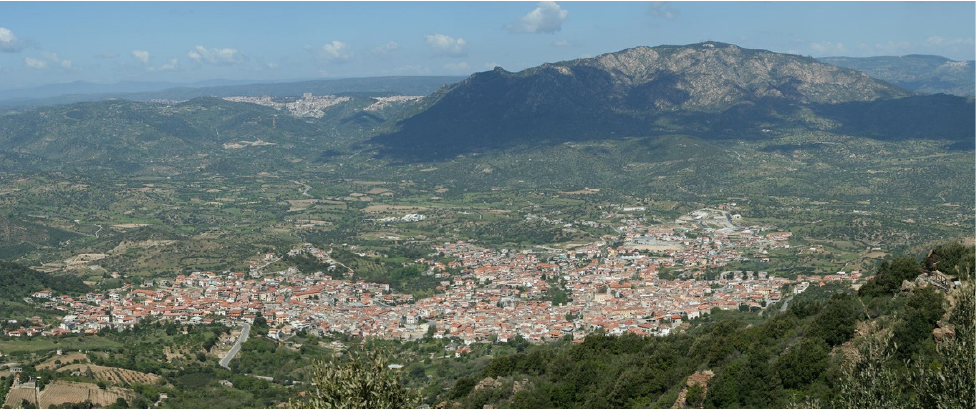
Figure 11. View of the mountainous regions surrounding Oliena (‘Oliena-Nuoro-Orune’. by Rafael Brix 2006/Wikimedia Commons is released under CC BY-SA 3.0).